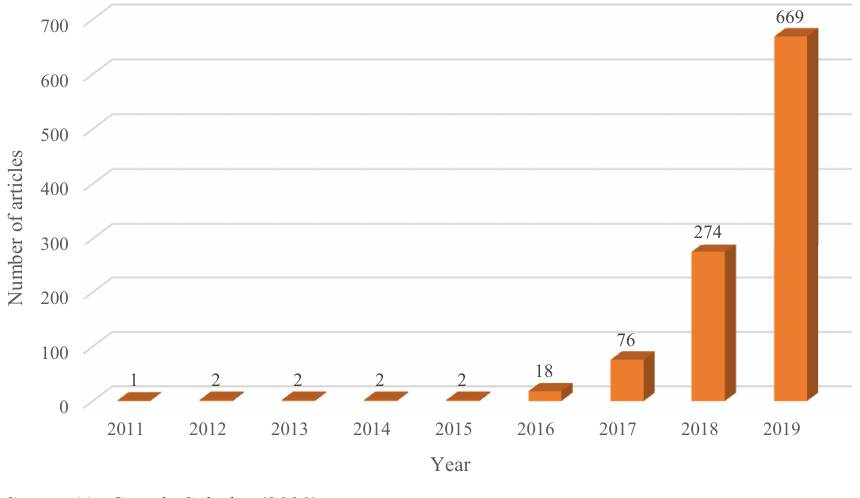
Figure 1. Number of published articles about